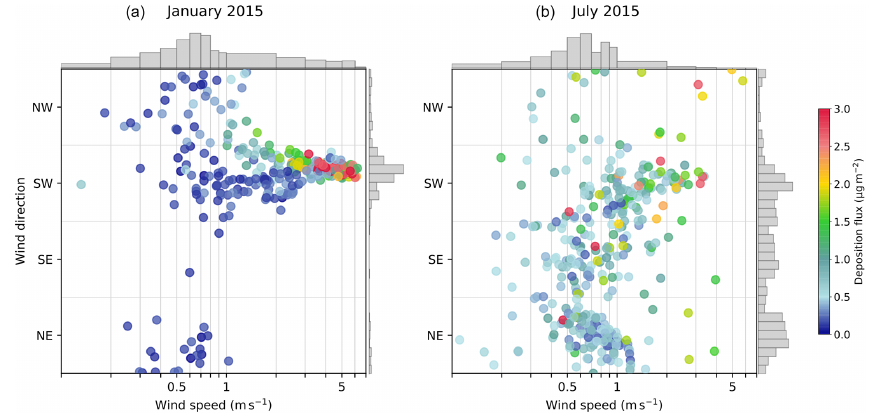
Figure 9. Modeled 2-hourly BC deposition flux (colors) averaged on glaciers between 33 and 34 ◦ S as a function of modeled 10m wind speed ( x axis) and wind direction ( y axis) in downtown Santiago (33.5 ◦ S, 70.65 ◦ W) for (a) January and (b) July 2015. Gray histograms indicate the density distribution of wind speed and direction on an arbitrary